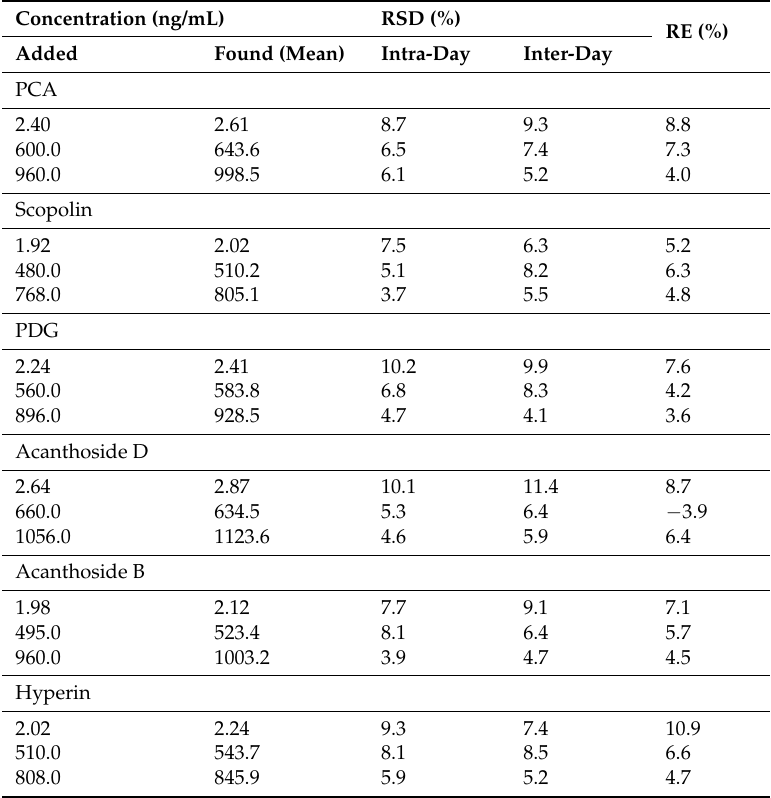
Table 1. Precision and accuracy of six components in rat plasma (in three validation days, six replicates at different concentration levels per day).